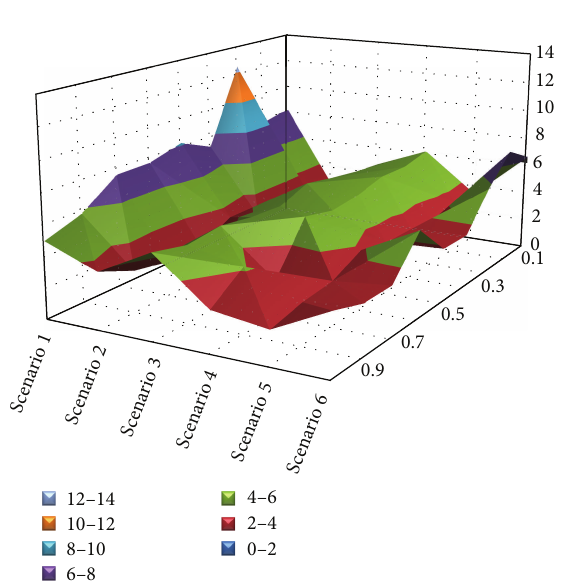
Figure 7: REP changes in different scenarios with respect to speed parameter.